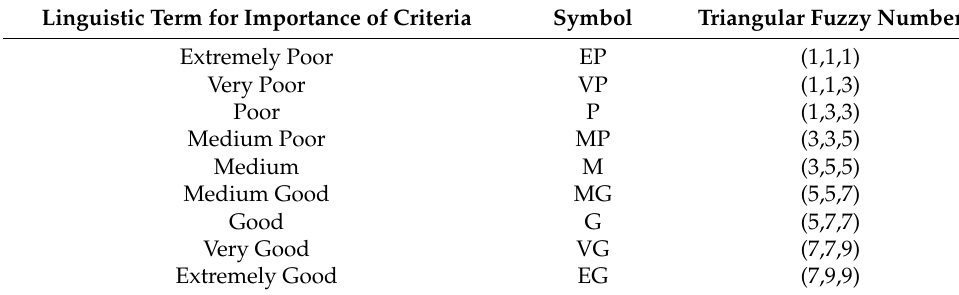
Table 1. Fuzzy scale used in the study.